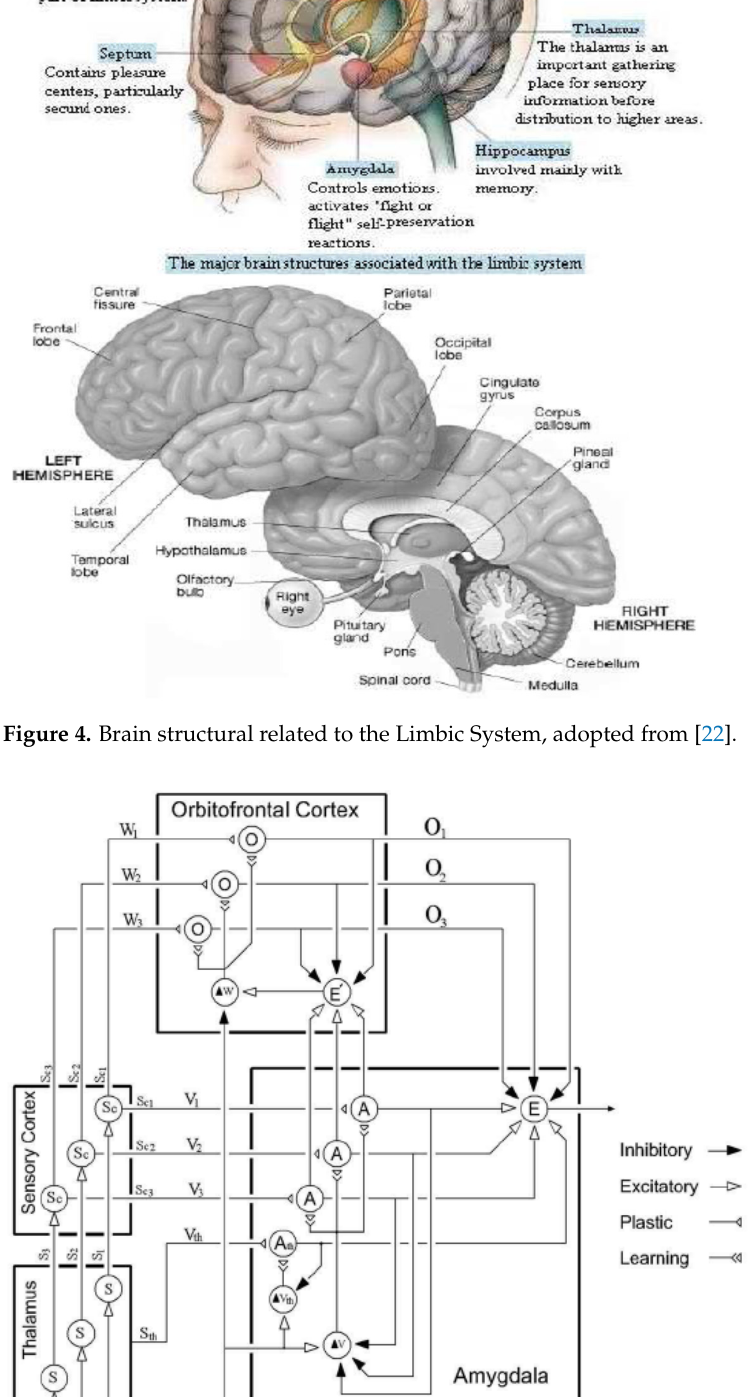
Figure 5. Graphical design of single-layer emotional controller, adopted from [22].